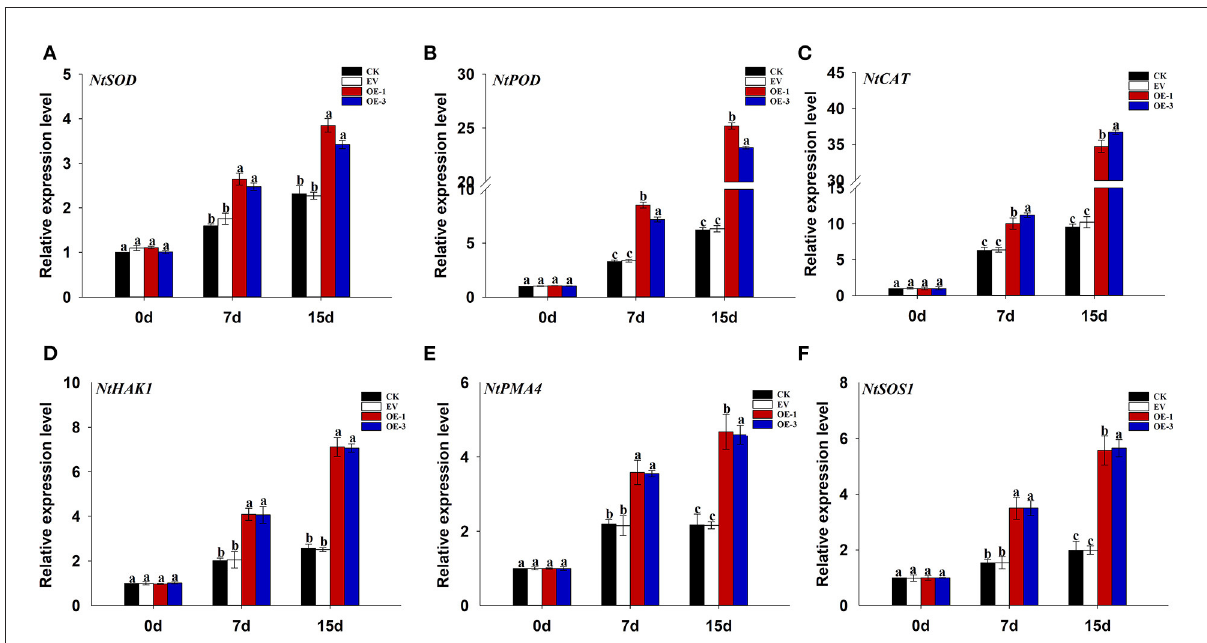
FIGURE7 Analysis of the changes in the expression of stress-related genes in the leaves of the transgenic tobacco lines overexpressing LpNAC17 under salt stress. (A) NtSOD . (B) NtPOD . (C) NtCAT . (D) NtHAK1 . (E) NtPMA4 . (F) NtSOS1 . The tobacco Actin gene was used as the internal control gene. Bars represent the SE of three independent replicates and the different letters indicate the significant difference at the same time point ( P <